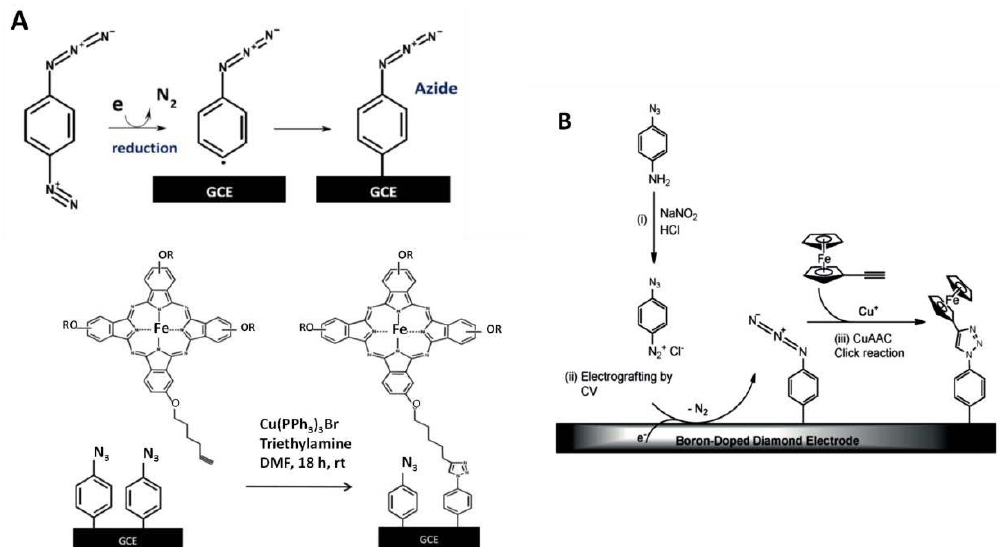
Figure 1. Functionalization of a GCE with azide groups by electrografting (top) and attachment of Fe(II) phtalocyanine on electrografted GCE via click chemistry ( A ); multistep functionalization of a BDDE by electrografting and attachment of ethynylferrocene via click chemistry ( B ). Reprinted from [28] ( A ) and [27] ( B ) with permission.